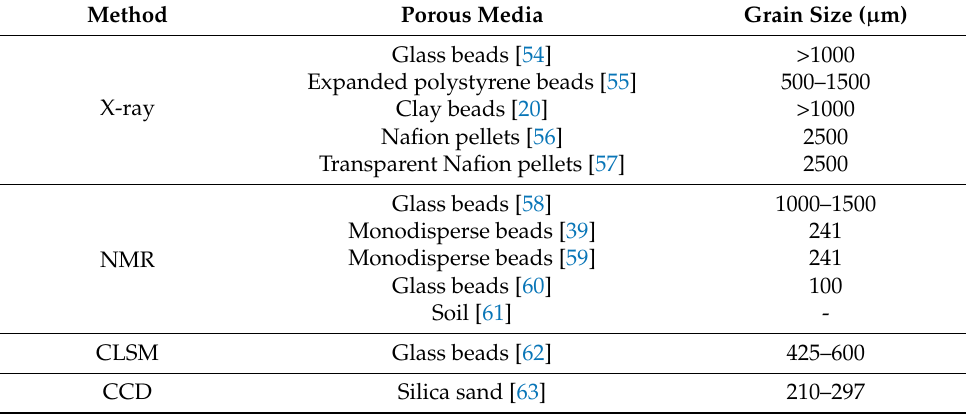
Table 1. Methods and